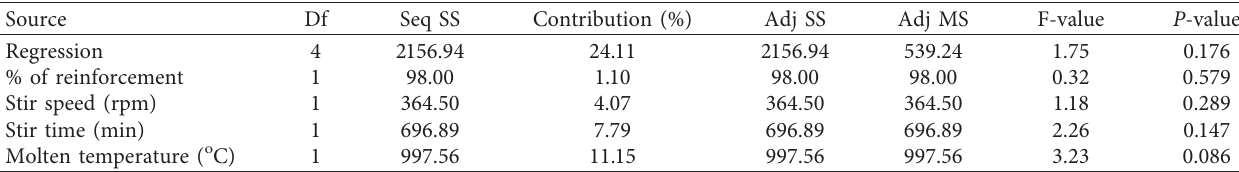
Table 9: Analysis of Variance for microhardness